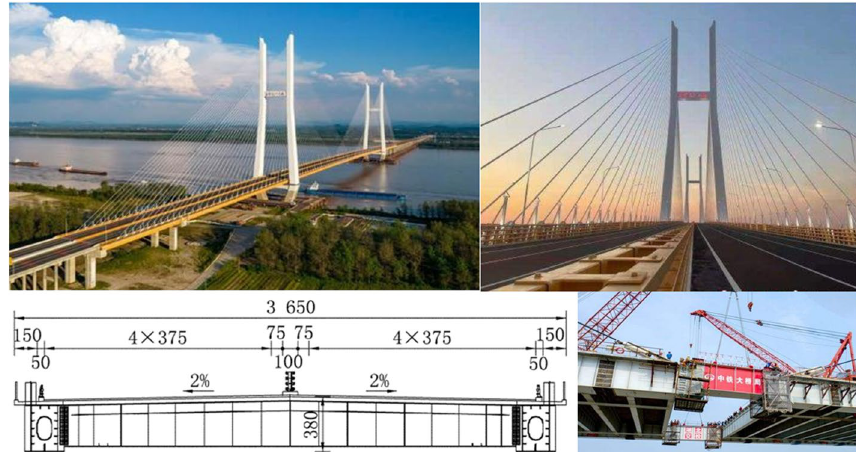
Fig. 3 The Chibi Yangtze River Highway Bridge and its composite girder